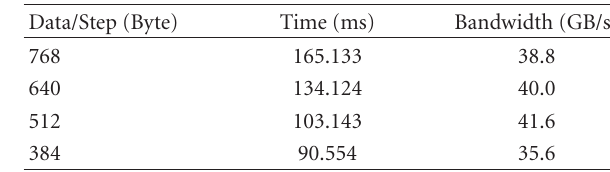
Table 1: E ff ects on the running time and total memory throughput of changing the amount of data read per